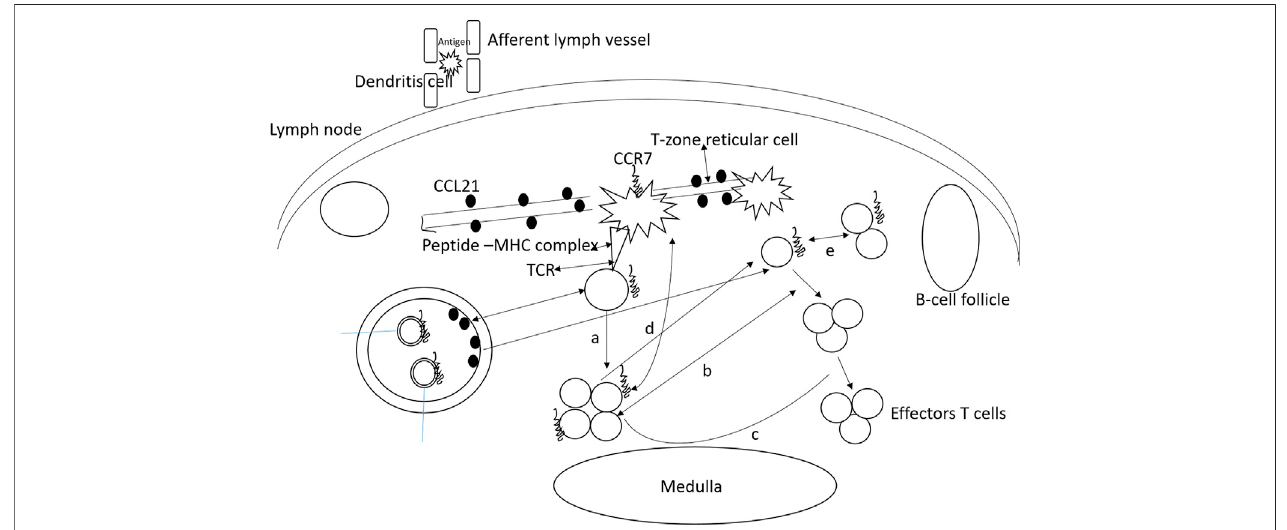
FIGURE 3 | Functioning of CCR7 in regulatory T-cells. Almost all regulatory T-cells express CCR7 and use it for entering into lymph nodes. These cells homing to thelymphnodeallowtheirinteractionwiththeantigensonthedendriticcells.Asaresult,theregulatoryT-cellsproliferateandexpanduponpresentationwiththeantigen. (A) Interfere with naïve T helper cell proliferation, (B) low number effector cells and inhibits differentiation, (C) regulatory T-cells exert suppressive activities by targeting dendritic cells, and (D) T-cells. (E) naive T cell conversion to regulatory T cells in the presence of low amount of